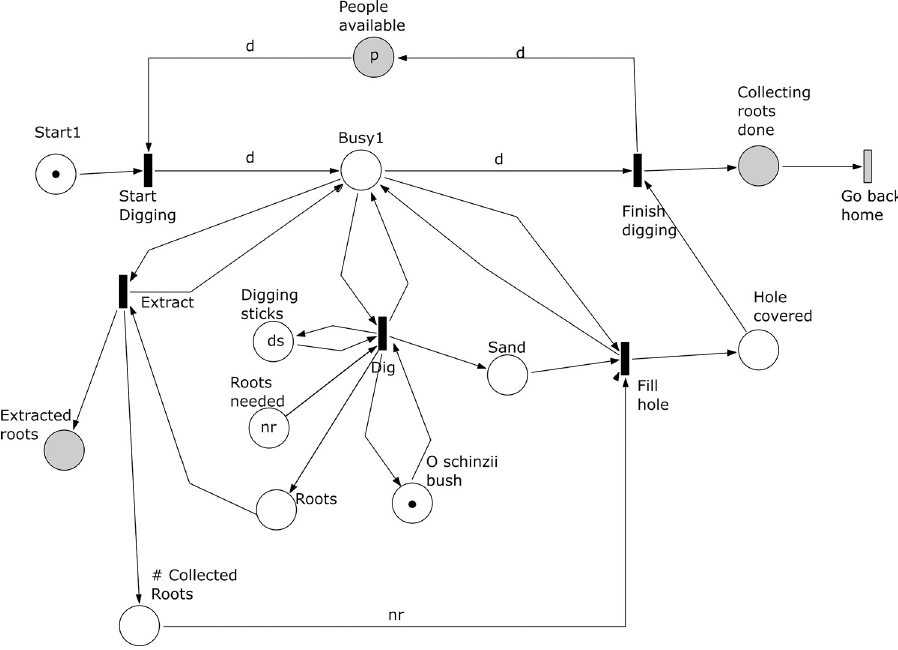
Fig 12. Subprocess 1 Dig Roots of the O . Schinzii model.